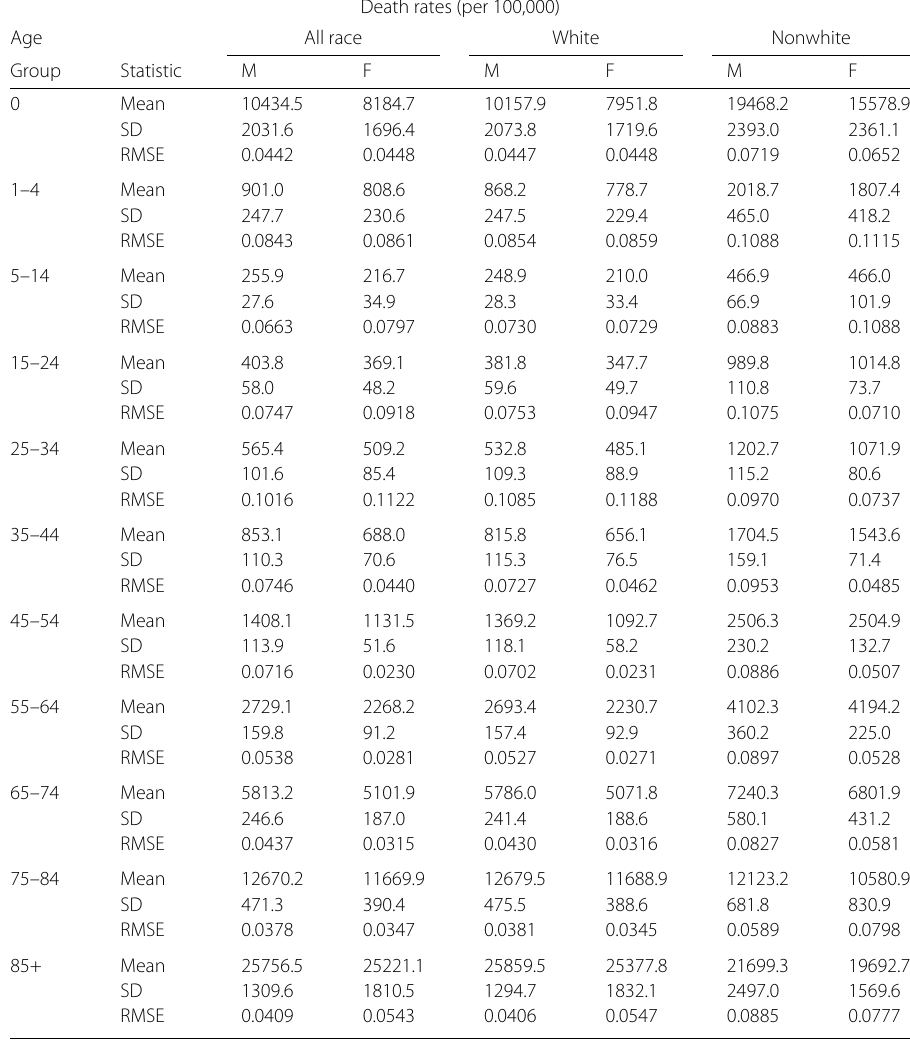
Table 4 For the balanced panel